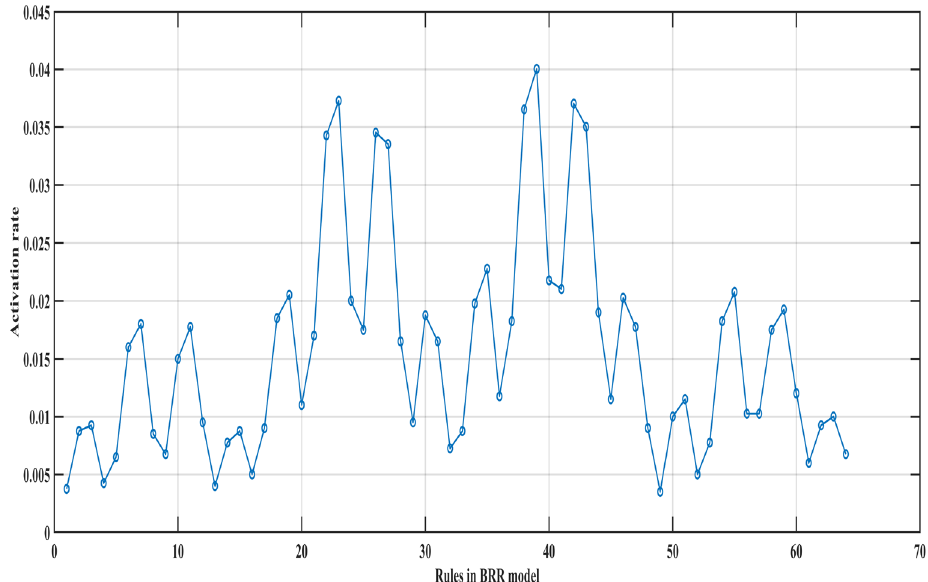
Figure 5. The activation rates of 64 rules in the BRB expert